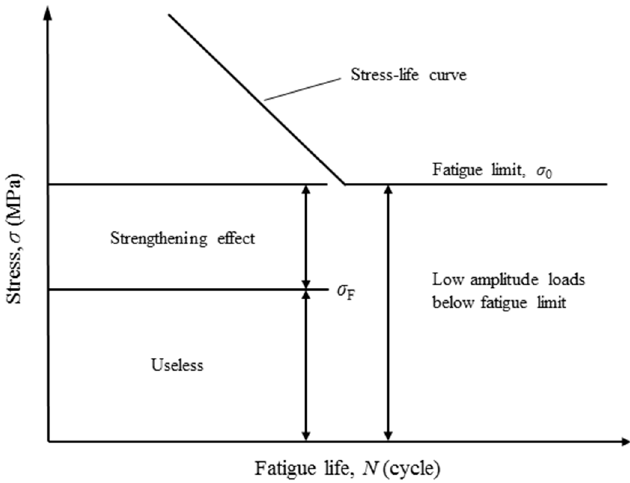
Figure 3. Low-amplitude loads below fatigue limit [27].